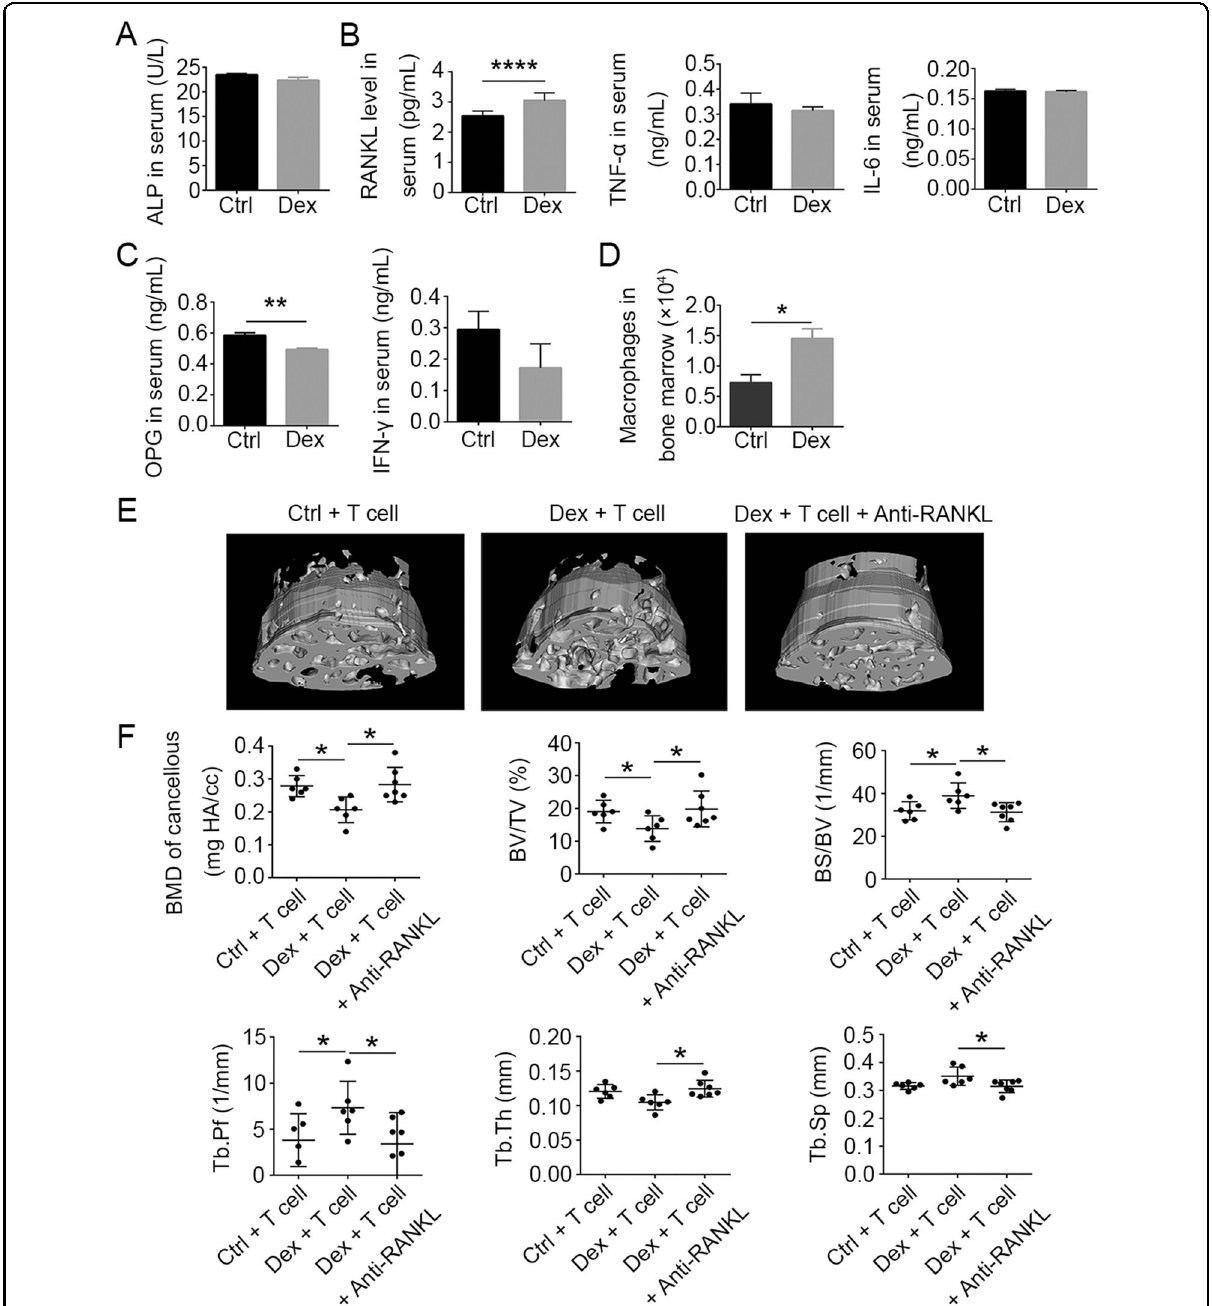
Fig. 4 Upregulation of RANKL in T cells mediates dexamethasone-induced osteoporosis. A Activity of alkaline phosphatase in serum from WT mice treated with or without Dex ( n = 5). Protein levels of RANKL, TNF- α , and IL-6 ( B ) and OPG and IFN- γ ( C ) in serum from WT mice treated with or without Dex ( n = 5). D Numbers of macrophages in bone marrow from WT mice treated with or without Dex on day 4 as analyzed by fl ow cytometry ( n = 5). E Micro-CT images of the femoral bone cancellous bone from SCID + T cells, SCID + T + Dex, and SCID + T + Dex + aRANKL. F Cancellous bone parameters were quantitated and compared between T-cell-reconstituted SCID mice ( n = 6), Dex-treated T-cell-reconstituted SCID mice ( n = 6), and anti-RANKL-treated Dex-treated T-cell-reconstituted SCID mice ( n = 7) after 4 weeks of treatment. Bars represent mean ±